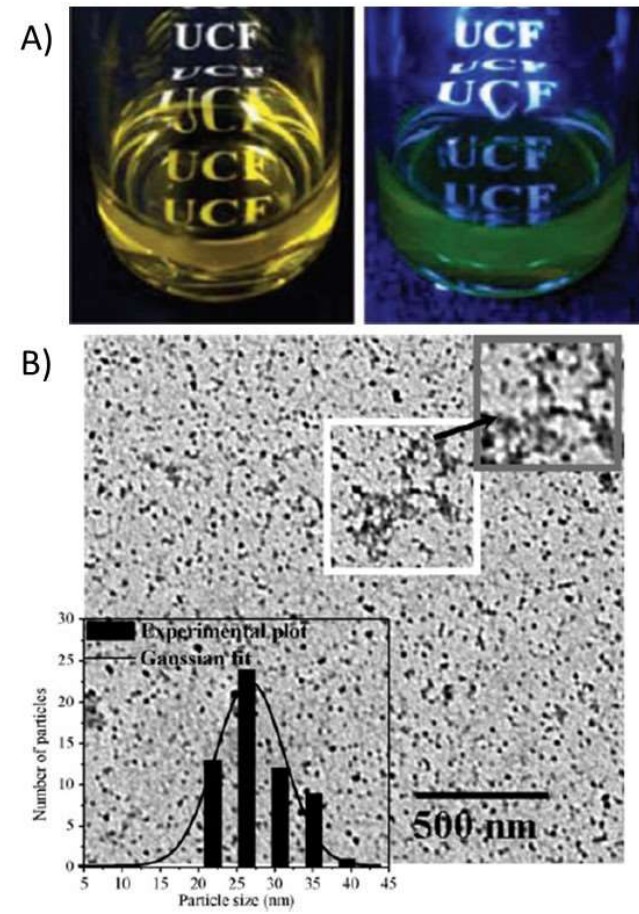
Figure 2. Demonstrates formation of FCSNPS using FITC. Daylight and emission pictures are shown in ( A ), and actual size and size distribution of the FCSNPs are shown in ( B ). Reprinted with